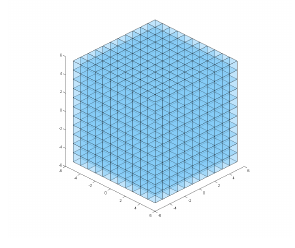
Figure 3. Regular 3D voxel